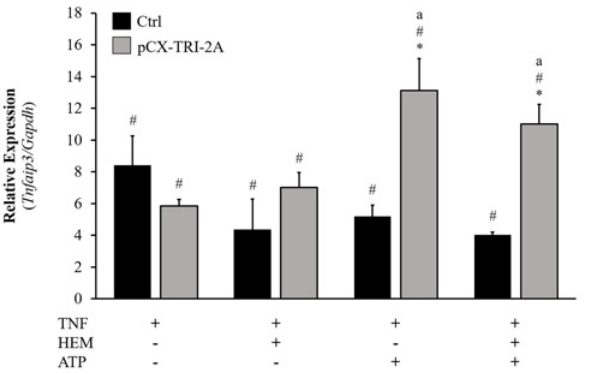
Fig 9. Changes in Tnfaip3 ( A20 ) mRNA expression in control (Ctrl) and pCX-TRI-2A-transfected cells. Cells were incubated with 50 ng/ml TNF- α for 16h, alone or in combination with 20 μ M hemin and/or 200 μ M ATP. Murine Tnfaip3/A20 mRNA was quantified by real-time PCR. Data (mean ± SD of three independent experiments) are normalized for Gapdh gene and expressed as fold change respect to the untreated cells. [ * ] indicates a significant difference between pCX-TRI-2A-transfected cells and control cells within the same treatment (t Student, p < 0.05); [#] indicates a significant difference as compared to untreated cells within the same cell type (ANOVA, p < 0.05); [a] indicates a significant difference as compared to TNF- α treatment alone within the same cell type (ANOVA, p <